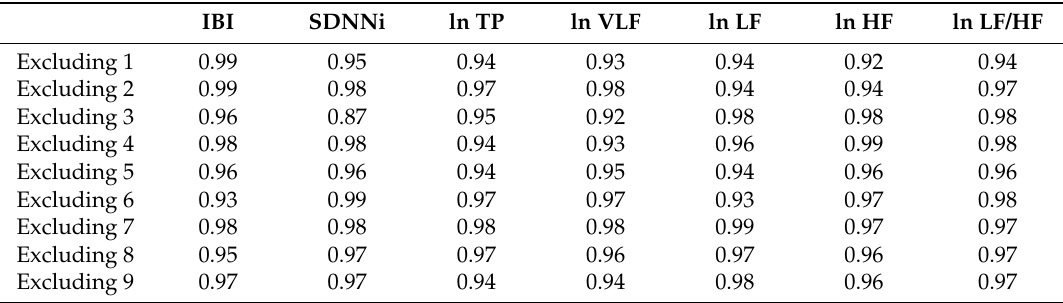
Table 1. HRV Bootstrap correlations for the nine participants average vs average excluding one participant.